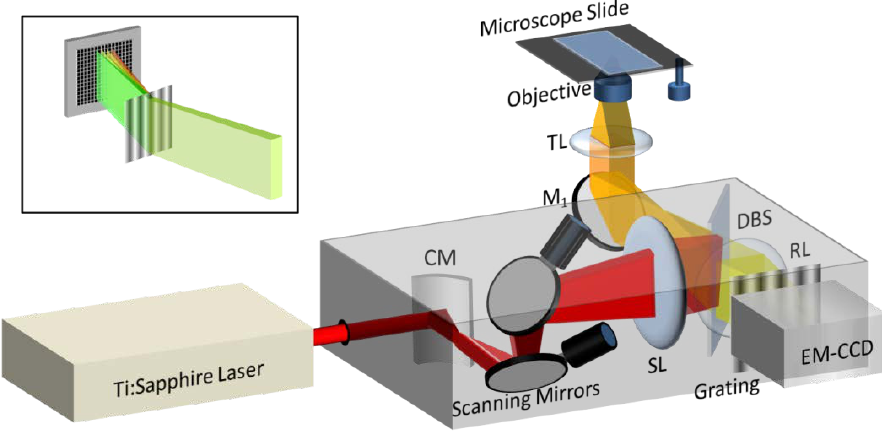
Figure 1. (Color online) Two photon excitation microscope with high spatial and spectral resolution using the line-scan excitation method. Significance of acronyms: CM, cylindrical mirror; SL, scanning lens; M , plane mirror; TL, tube lens; DBS, Dichroic beam 1 splitter; RL, imaging relay lens. Inset: Instantaneous spectrum measurement concept used by the two-photon excitation microscope in a line-scan